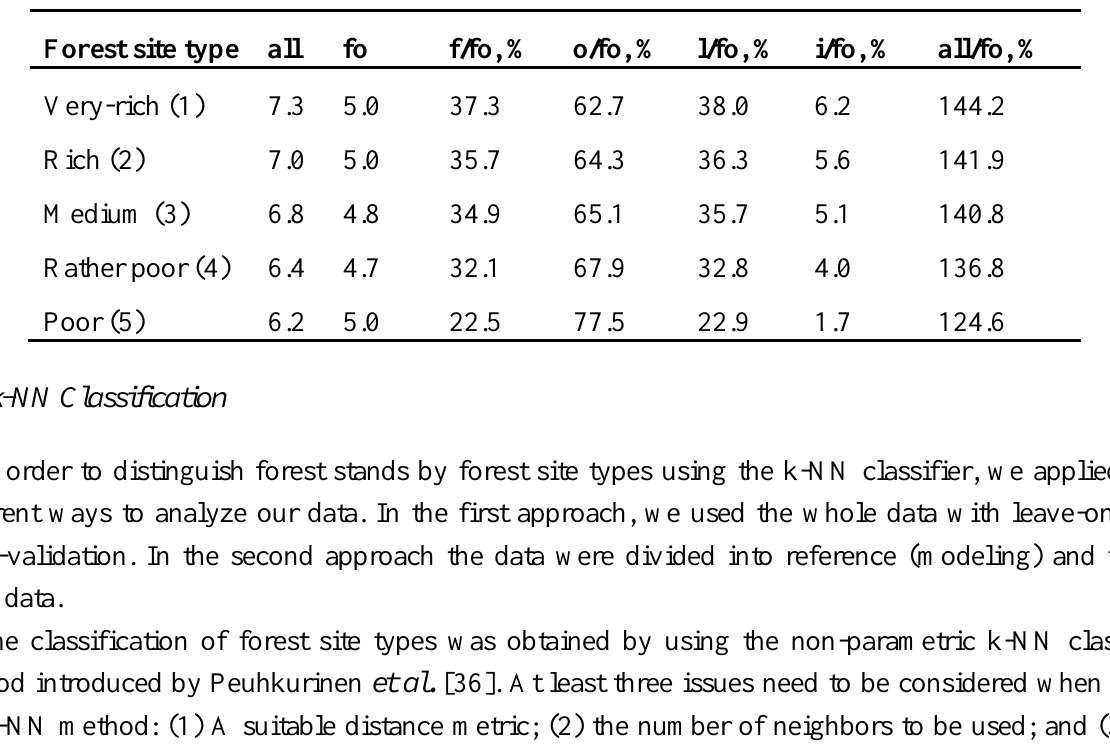
Table 2. Numbers of laser echoes/m 2 by forest site types and proportions (%) of the different types of echoes including the z value and intensity value in the whole data. The letters f, o, l and i indicate the first, only, last, and intermediate echoes, respectively, whereas fo is the sum of first and only